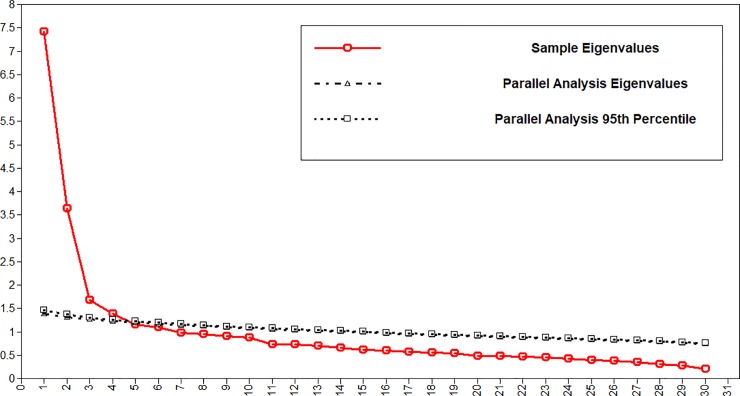
EFA parallel analysis.